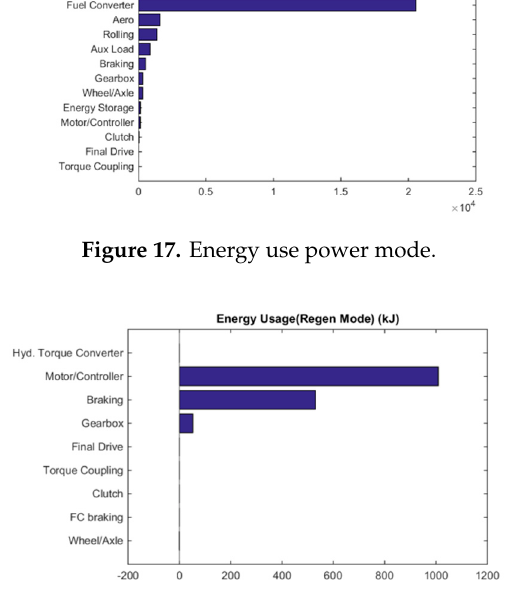
Figure 18. Energy use regeneration (regen) mode.